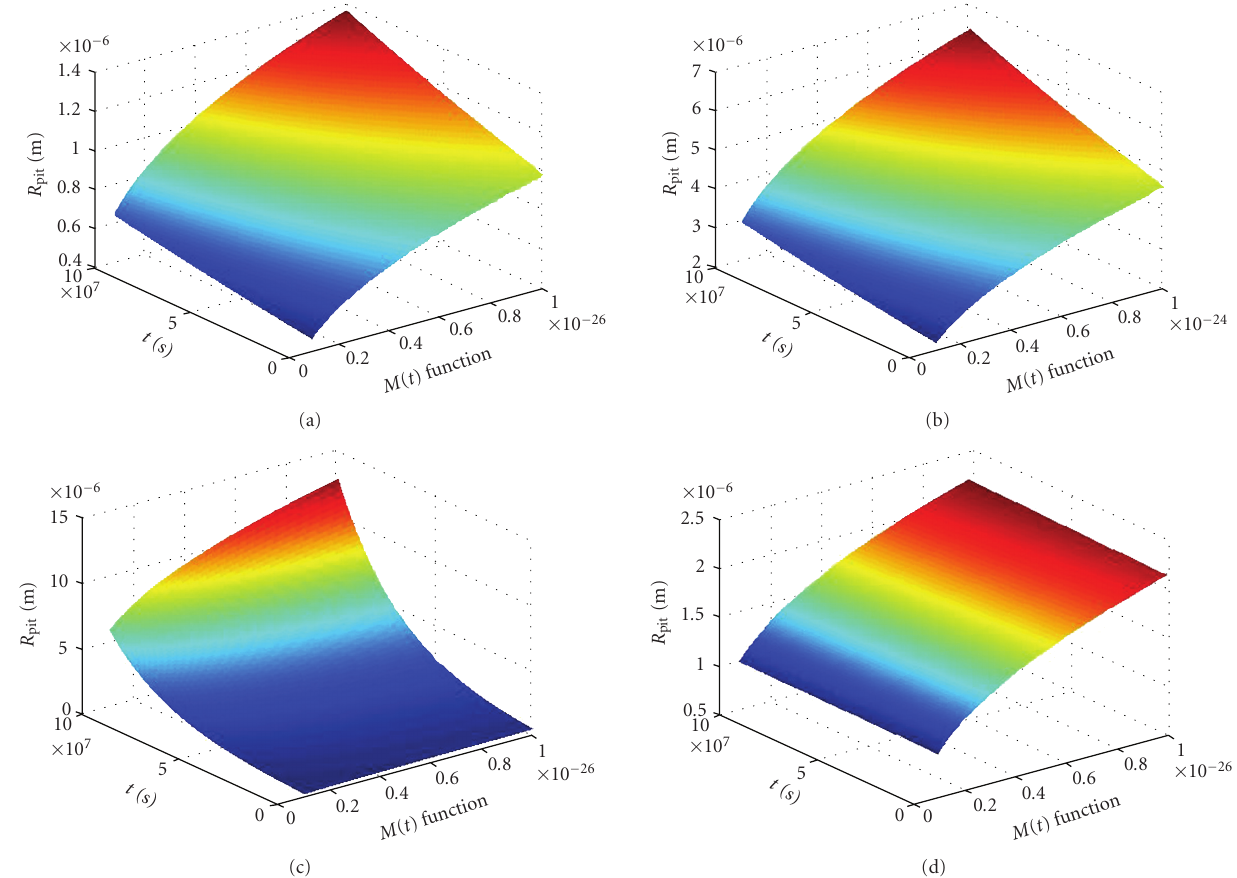
Figure 3: The range of M ( t ) function was estimated based on the designation of (25) and experimental data [17] and using ε f 0 = ε M 0 ≈ 5 . 1 · 10 − 22 J value. Simulations were run for di ff erent range of M ( t ) function and for di ff erent values of k M N im parameter. Figures (a) & (b) indicate pit radii time profile for range of M ( t ) ∈ [10 − 27 ,10 − 26 ] and M ( t ) ∈ [10 − 25 ,10 − 22 ], respectively. Estimation intervals of M ( t ) functions were taken by calculations based on given by standard tables of chemical potentials for solutions and for free energy per atoms, k M N iM ∼ 10 − 8 which was estimated based on (30). Figures (c) & (d) indicate pit radii time profile for fixed range of M ( t ) functions M ( t ) ∈ [10 − 27 ,10 − 26 ] but for di ff erent k M N iM parameter, k M N iM ∼ 10 − 7 and k M N iM ∼ 10 − 9 ,